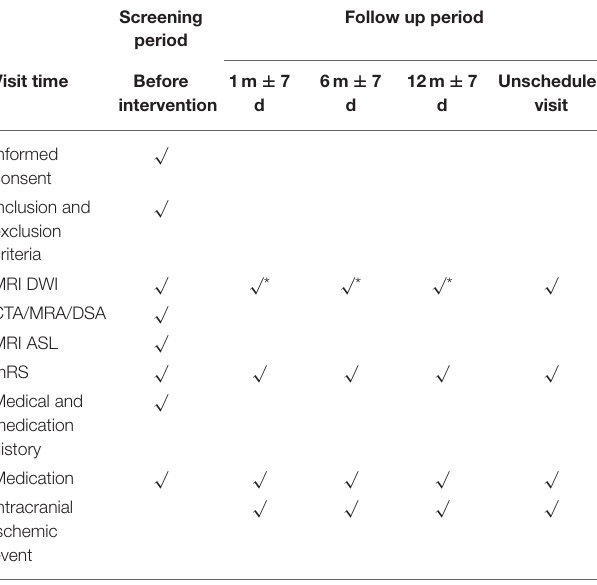
TABLE 1 | Inclusion and exclusion criteria for patient selection. Inclusion criteria Exclusion criteria